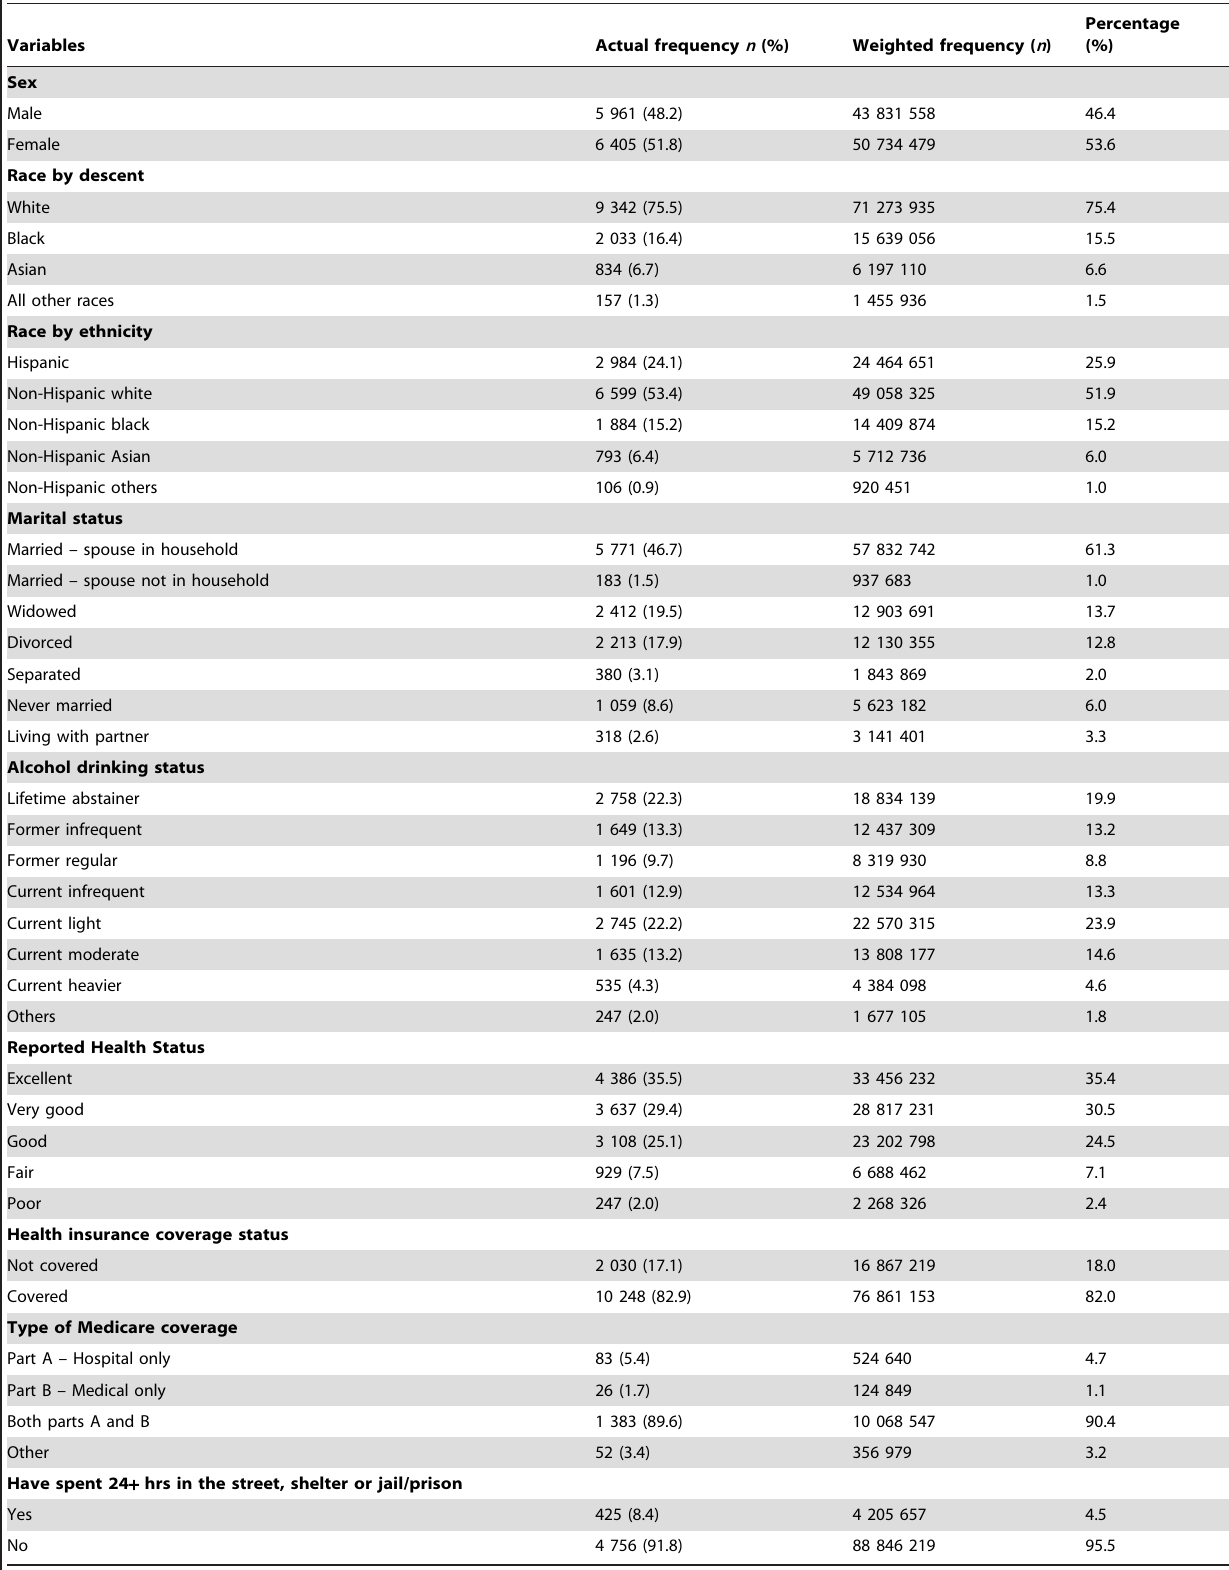
Table 1. Distribution of Respondents by Socio-Demographic